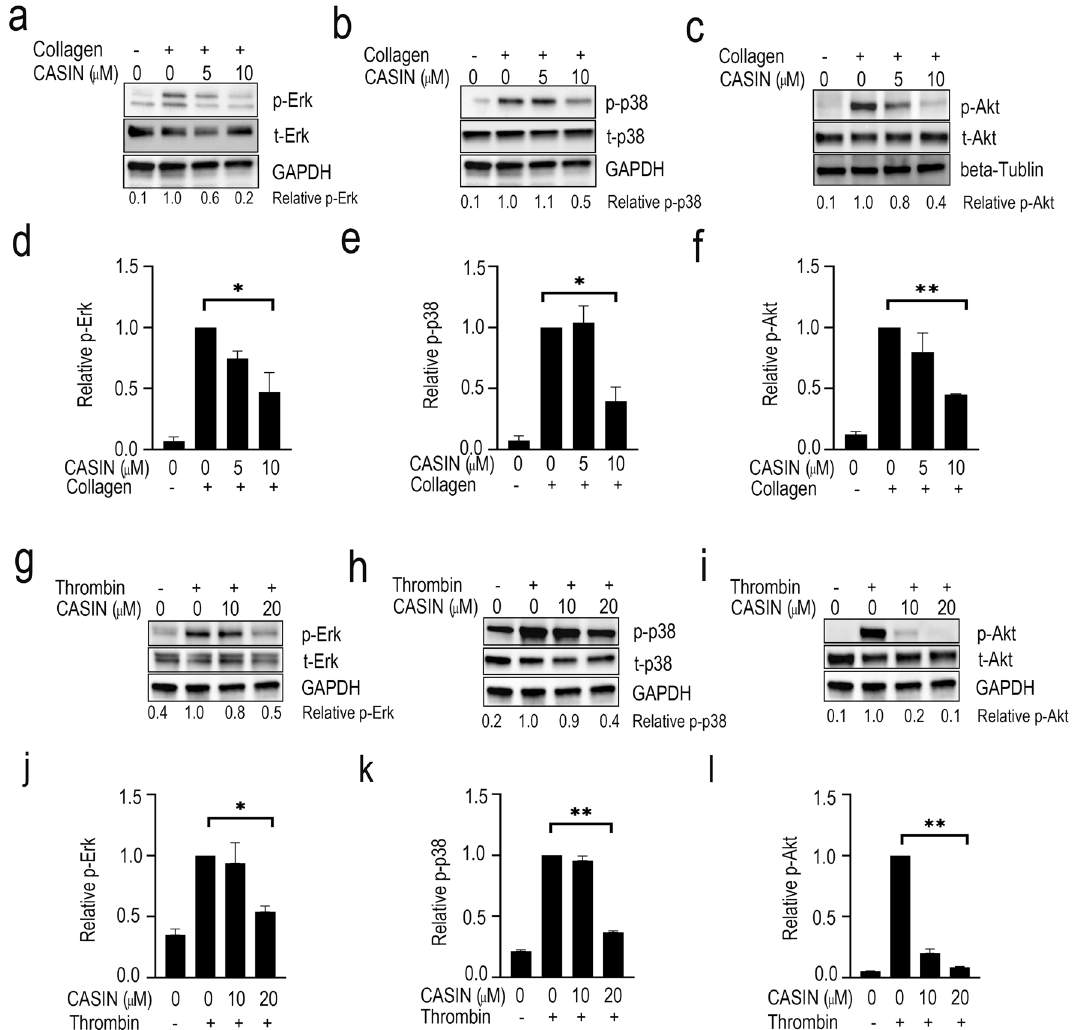
Figure 4. CASIN blocked activation of ERK, p38-MAPK and Akt. CASIN was added to washed human platelets two minutes prior to addition of collagen or thrombin. Samples were incubated at 37 °C with constant stirring in a Chrono-Log aggregometer. The reactions were terminated by adding 4 × sample buffer, processed for Western blotting and probed for the total and phosphorylated ERK ( a and g ), p38-MAPK ( b and h ), Akt ( c and i ) and GAPDH ( a , b , g , h , i ) and beta-Tubulin ( c ) as detailed in methods. The GAPDH blot shown in ( a ) is the same as in ( b ); and the GAPDH blot shown in ( g , h and i ) are the same control. The graphs indicate densitometry analyses using the expression ratios of ERK ( d and j ), p38-MAPK ( e and k ) and Akt ( f and l ) densitometry data. (Mean ± SEM, n = 3, * p < 0.05, ** p <